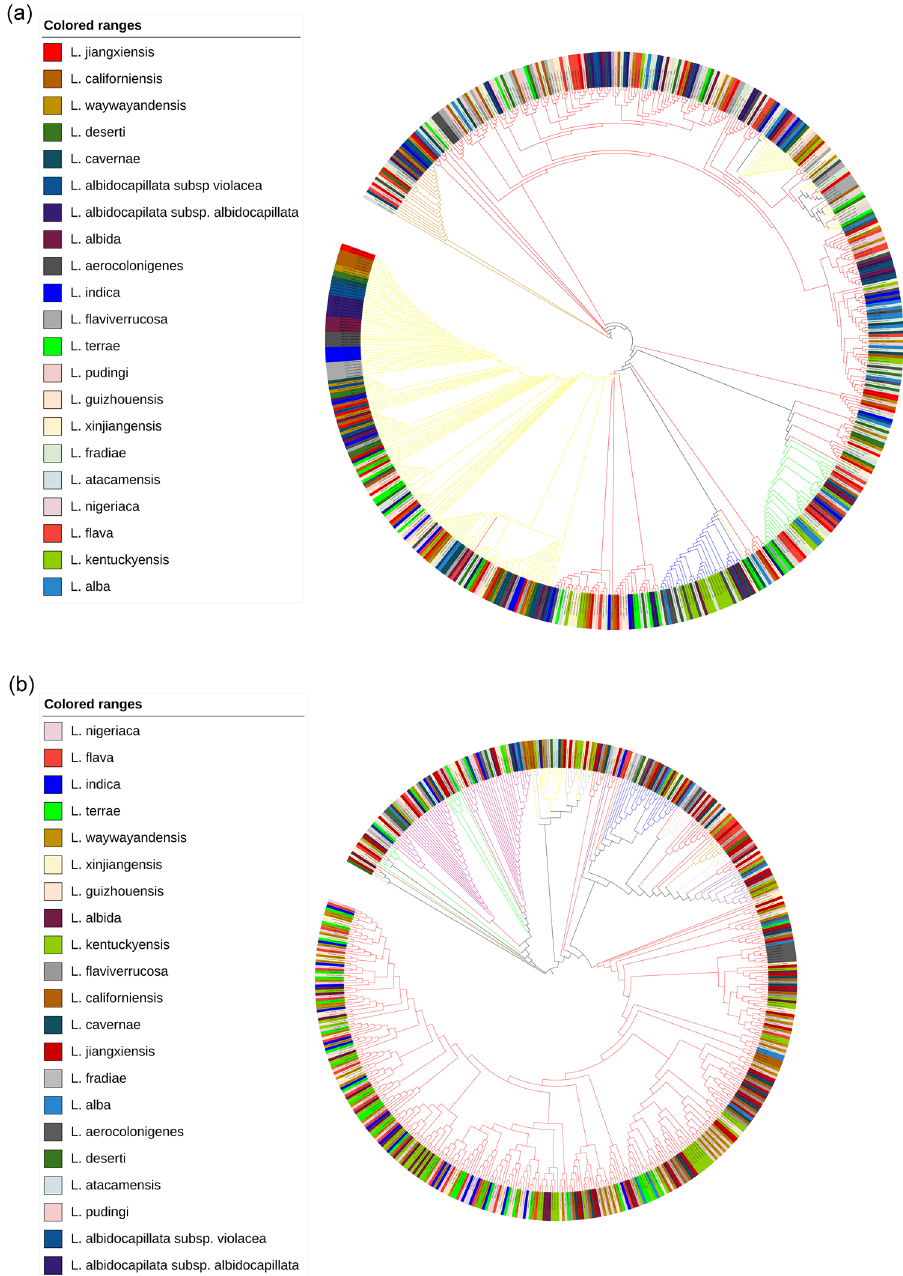
Figure 11. Phylogenetic analysis of ( a ) condensation and ( b ) ketosynthase domains of NRPS and PKS genes in Lentzea genomes by Neighbor-joining method against NaPDoS database domains. Leaves are coloured to represent different Lentzea species, while coloured branches display domain class of database domains (A) NRPS C domain: Yellow = DCL, Red = LCL, Green = cyc, Blue = modAA, Light Brown = start, Purple = C. (B) PKS KS domain: Yellow = enediyne, Red = modular, Green = FAS, Blue = hybrid KS, Brown = trans, Purple = KS1, Pink = typeII, Light pink =